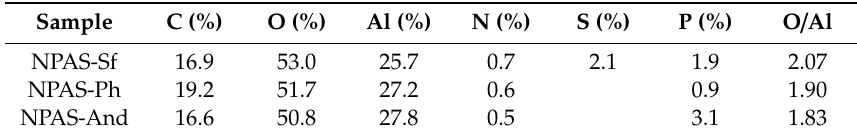
Table 1. Average atomic concentration percentages of the main chemical elements found on NPASs